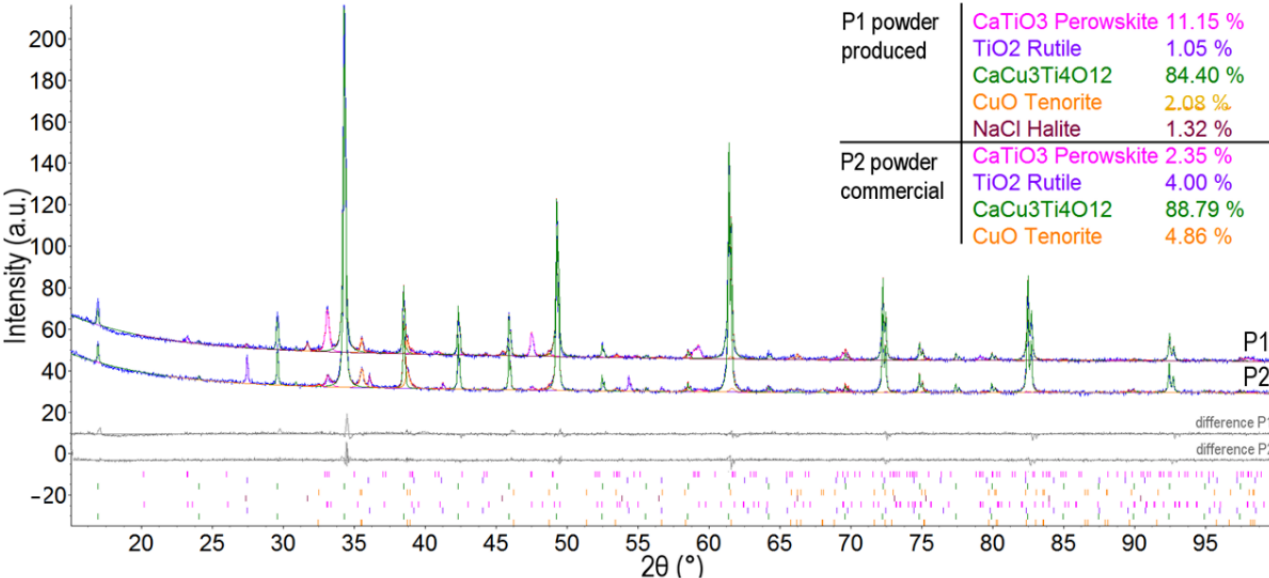
Figure 1. XRD patterns of P1 powder produced using the molten salt route and P2 commercial powder. Grey color indicates the “difference between fit and model”.